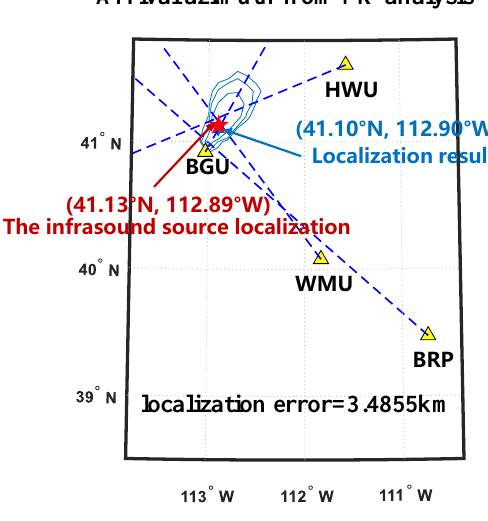
Figure 14. The localization result of the infrasound source by fusing the FK arrival azimuth estima- tions. (The three blue contour curves are credibility contour curves with Bayesian credibility values of 0.75, 0.90, and 0.95, respectively; the red pentagram indicates the location of the infrasound source; and the blue hexagram indicates the distributed array localization